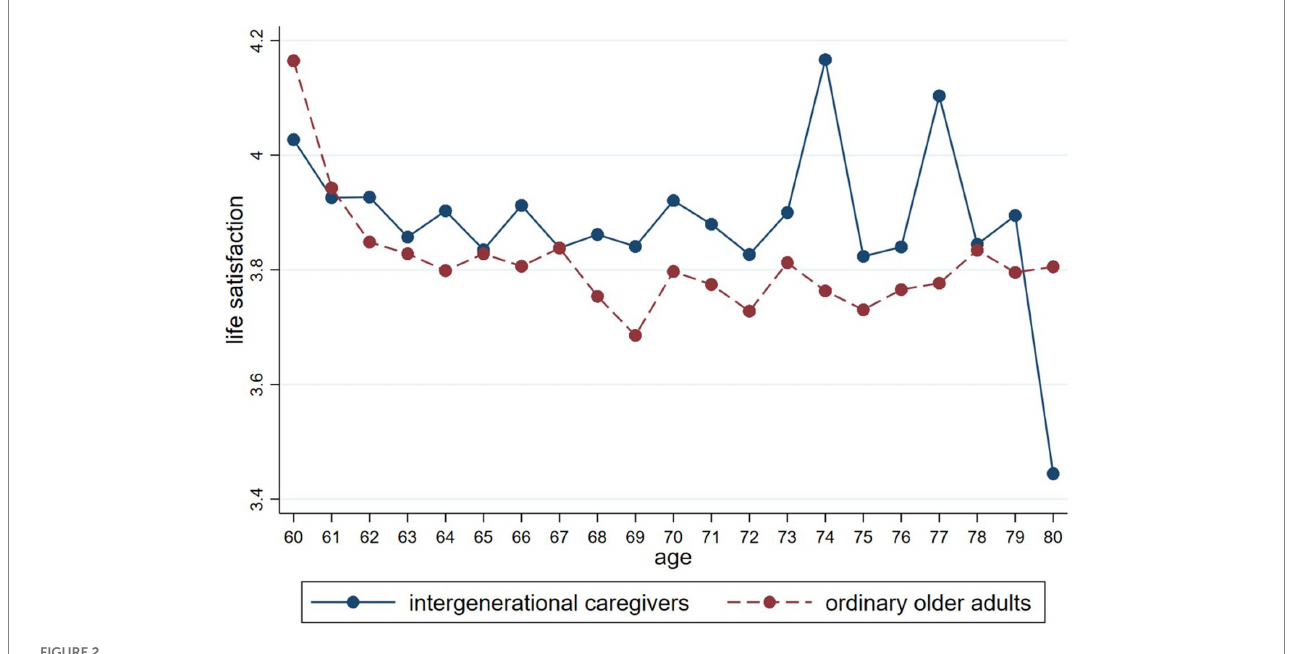
FIGURE 2 Comparative results by